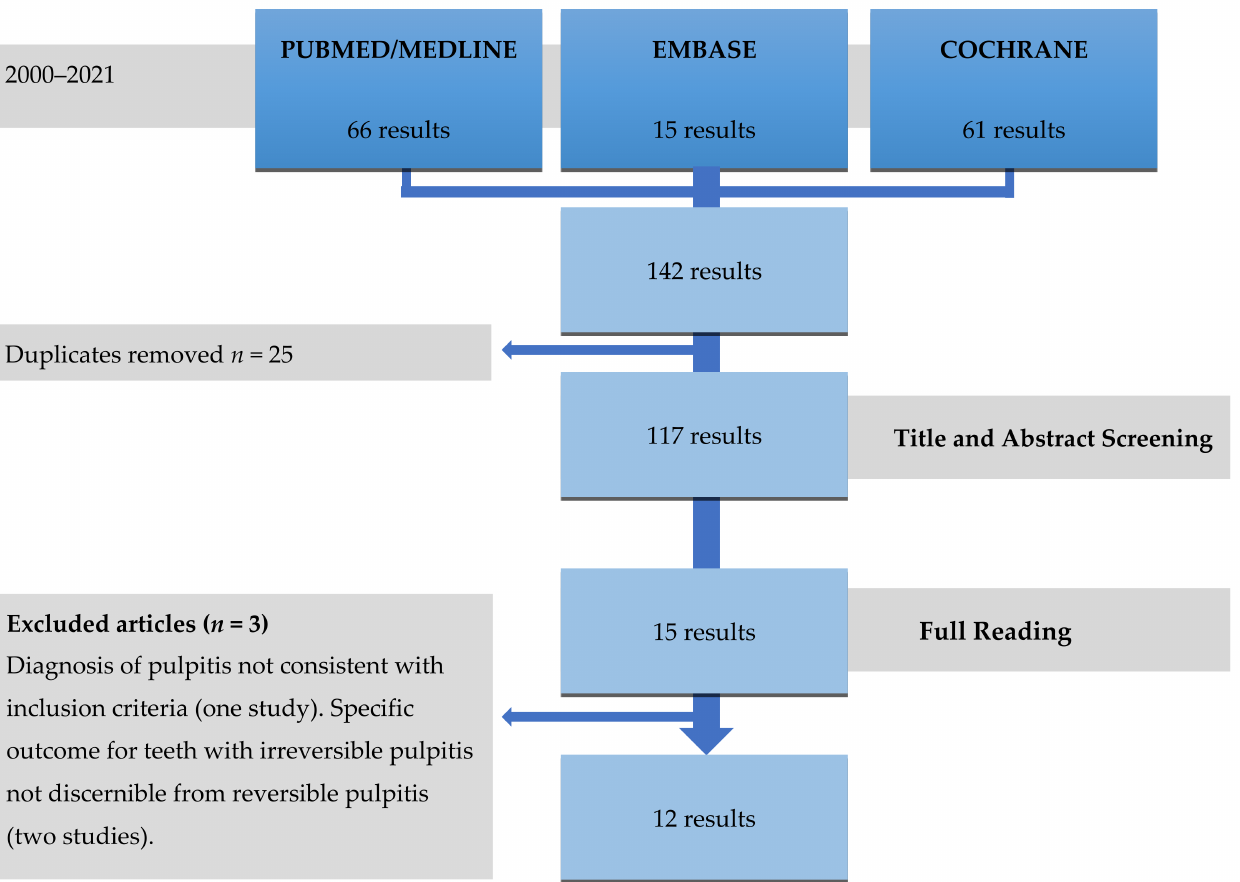
Figure 1. Flowchart of the search strategy and steps of this systematic